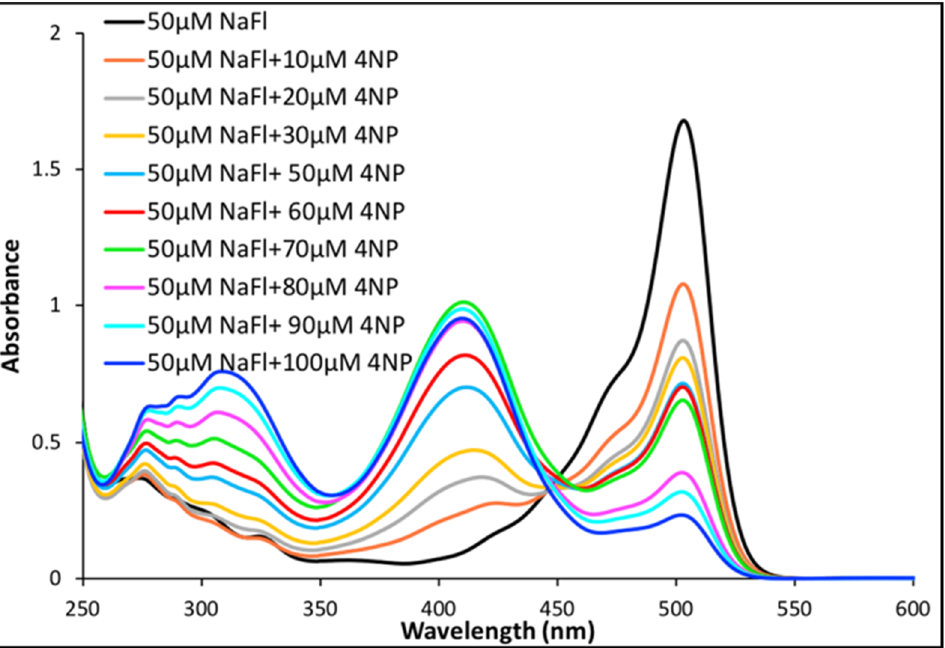
Figure 4. Absorption spectra of NaFl in the presence of different concentration of 4NP in MeCN. As indicated in Table S1 of Supporting Information, the solution mixture of NaFl and 4NP contain a fixed 250 µ L of water in each 5 mL solution of MeCN. In order to